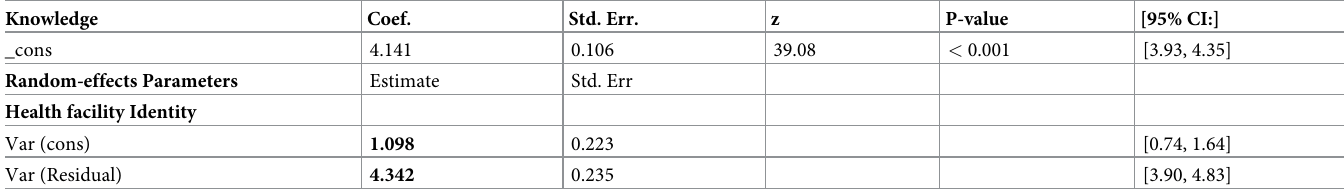
Table 4. An empty model for multilevel analysis for facility level factors associated with PP-IUCD Knowledge in Amhara regional state health providers Ethiopia